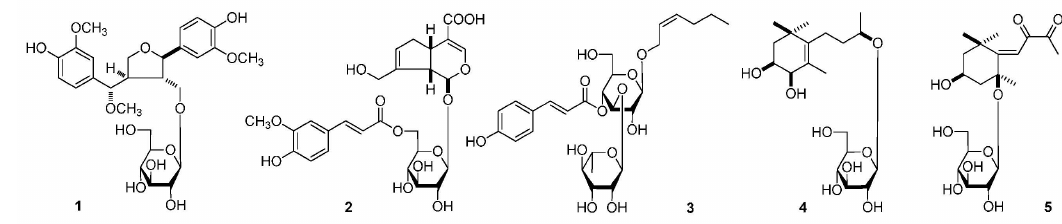
Figure 1. The new compounds ( 1 – 5 ) obtained from L. triphylla.